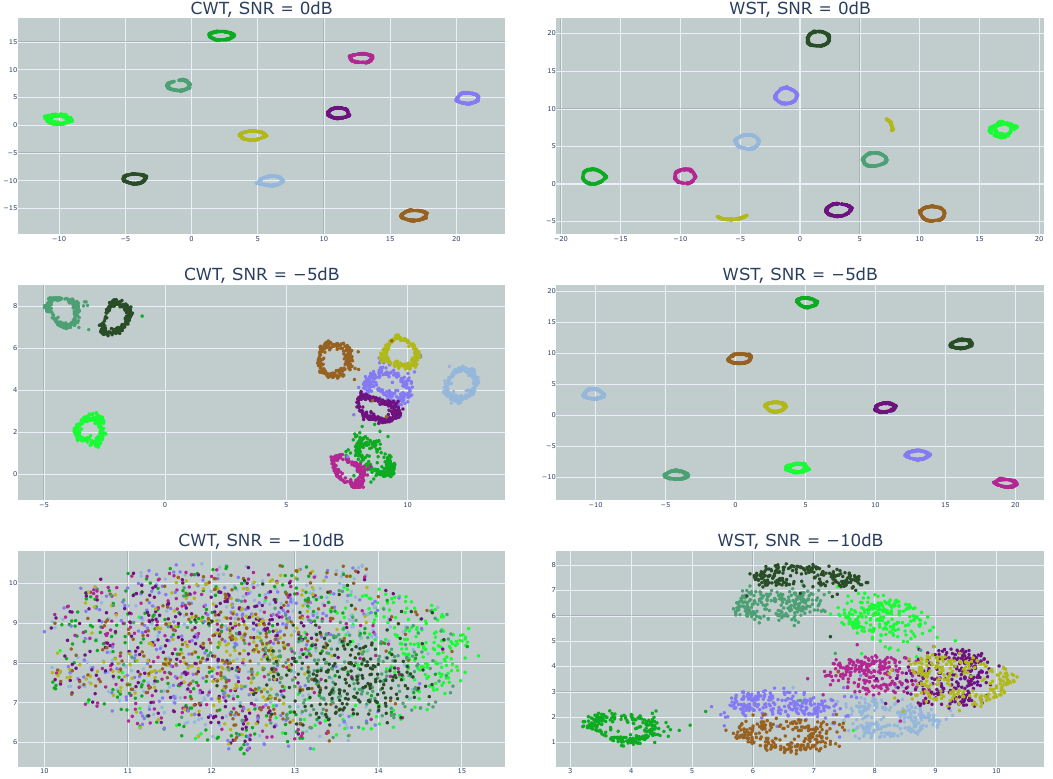
Figure 13. Clustering results using UMAP with WST and CWT for different SNR